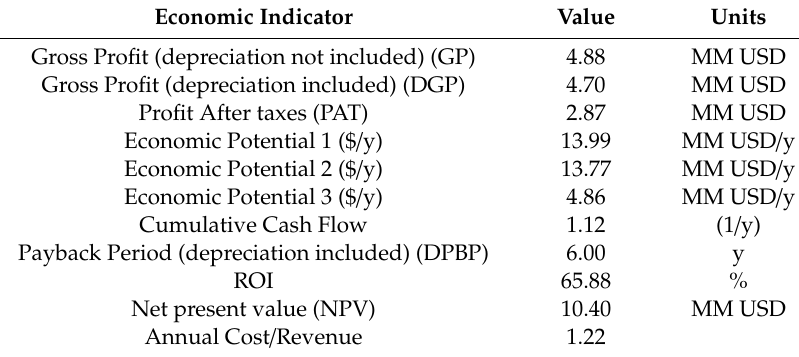
Table 7. Economic indicators for the mass integrated approach for shrimp